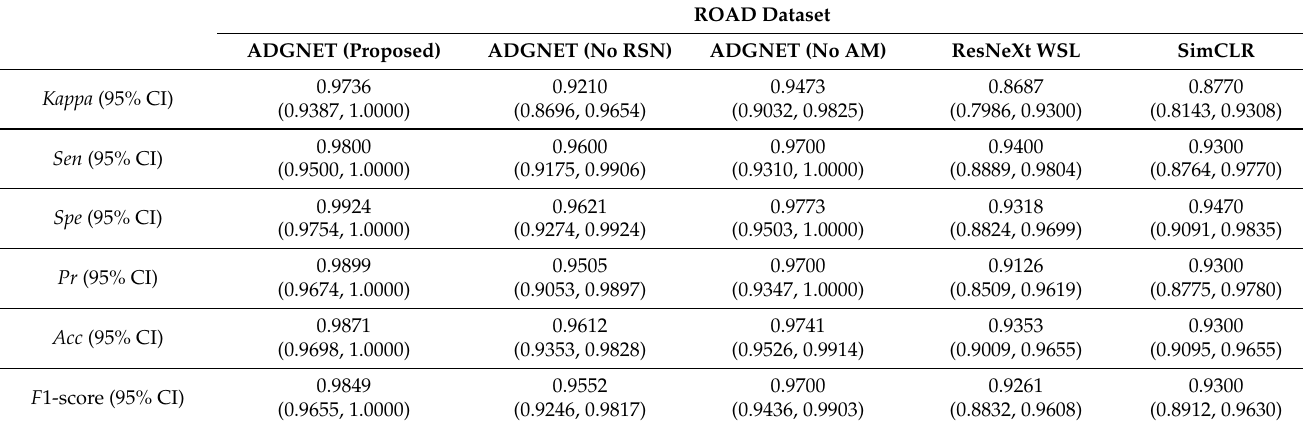
Table 3. Performance indices of the proposed ADGNET framework of the experiment B and the average performance of the two SOTA models on the ROAD